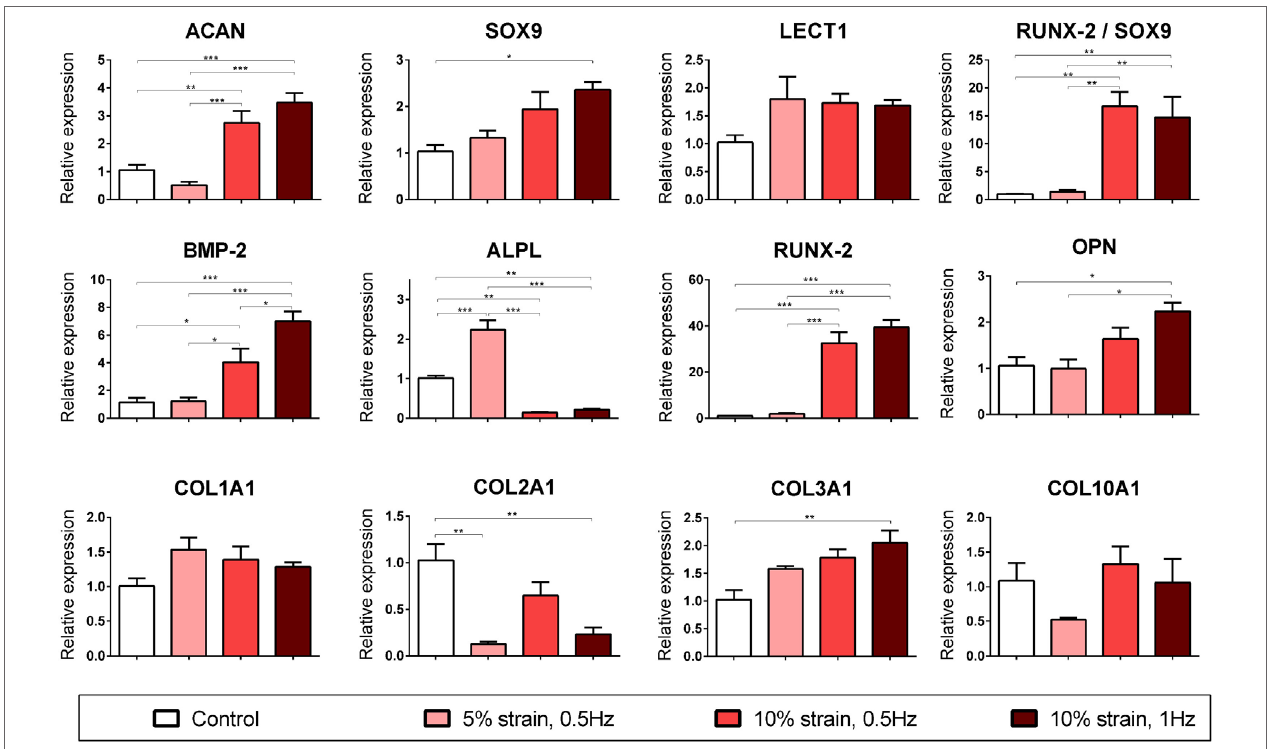
FigUre 4 | Chondrogenic and osteogenic gene expression of multipotent stromal cells (MSCs) encapsulated in fibrin hydrogels and cultured in media supplemented with chondrogenic growth factor transforming growth factor- β 3 for 21 days. Cyclic tensile strain was found to promote endochondral ossification of chondrogenically primed MSCs in a magnitude- and frequency-dependent manner. Data are presented as fold changes, relative to the non-loaded (control) group. RUNX2/SOX9 ratio is presented as fold change/fold change. Significant differences are indicated where present (* p < 0.05; ** p < 0.01; *** p < 0.001; n = 5). See Table 1 for explanation of gene symbols.